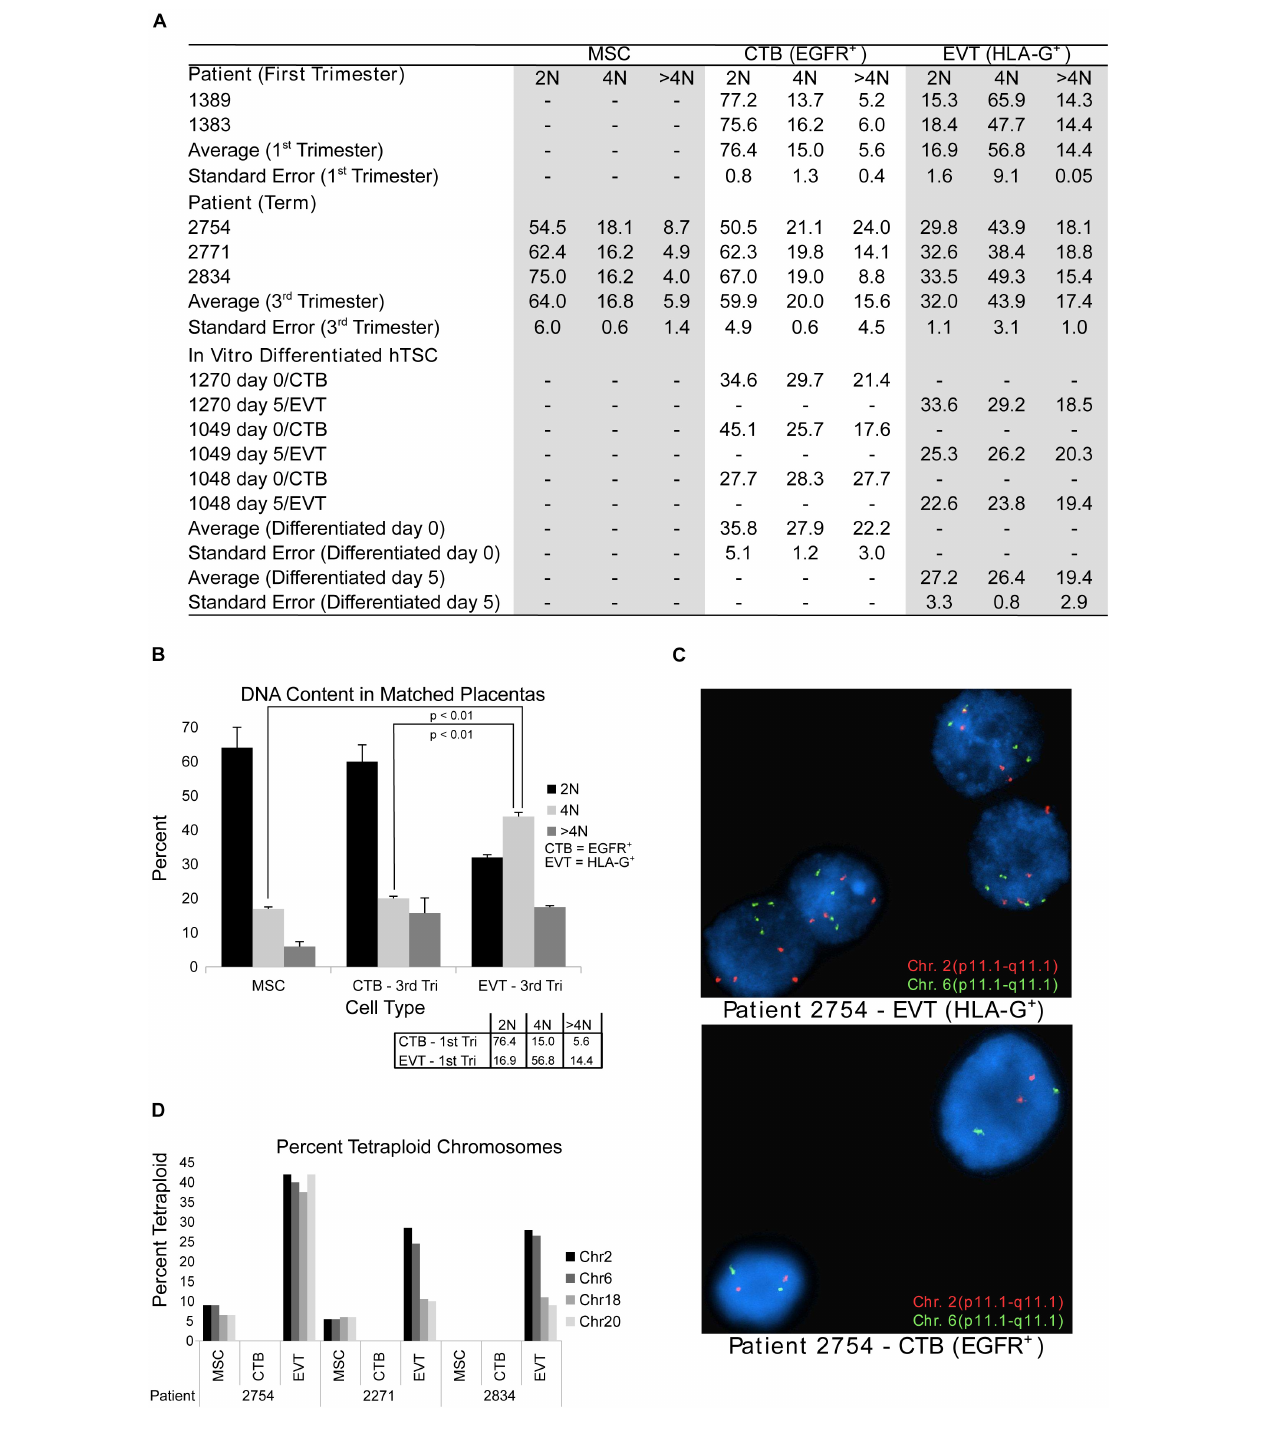
FIGURE 2 | DNA content flow cytometry and cytogenetics analysis. (A) Table showing results of DNA content flow cytometry analysis in umbilical cord-derived mesenchymal stem cells (MSC) from term placentae, cytotrophoblast (CTB) and extravillous trophoblast (EVT) from first trimester or term placentae CTB and EVT, and human trophoblast stem cells (hTSCs) that are either undifferentiated (day 0) or differentiated (through a 5-day protocol) into EVT in vitro . (B) DNA content as determined by flow cytometry from matched CTB, EVT, and MSC from three term placentae. Box in the bottom right corner shows the mean percentage of cells in each ploidy group of matched CTB and EVT from two first trimester placentae as determined by flow cytometry. (C) Example images from FISH analysis of matched EVT and CTB from one term placenta. Images show probes targeting chromosome 2 (red) and chromosome 6 (green). (D) Bar graph showing the percentage of cells determined by FISH to be tetraploid (chromosomes 2, 6, 18, and 20) in MSC, CTB, and EVT from three term placentae.